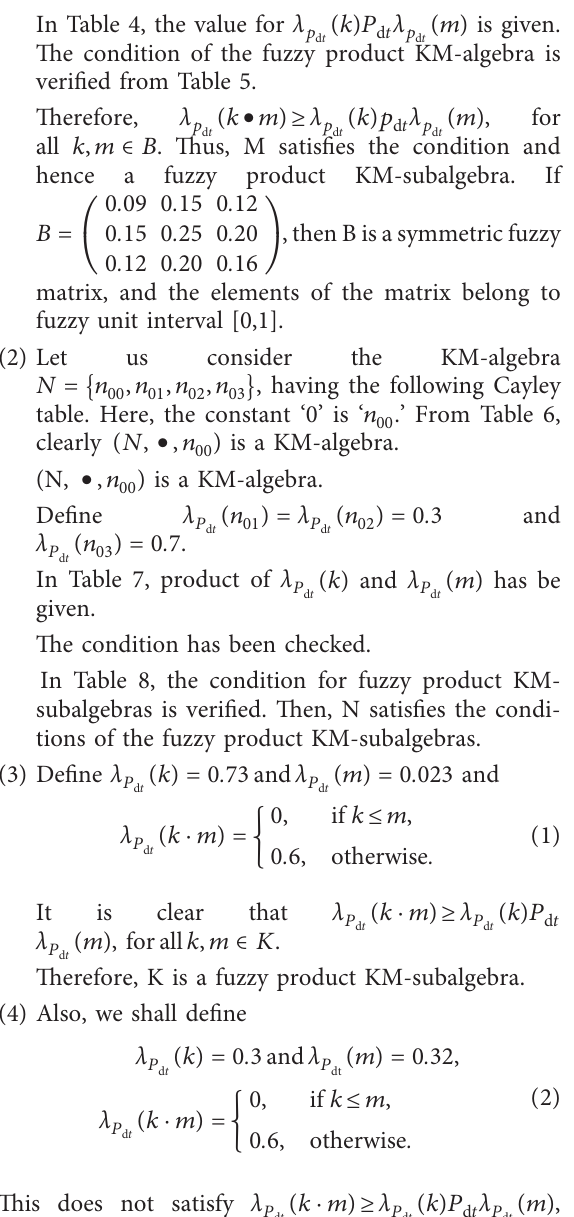
Table 1: Binary operation.